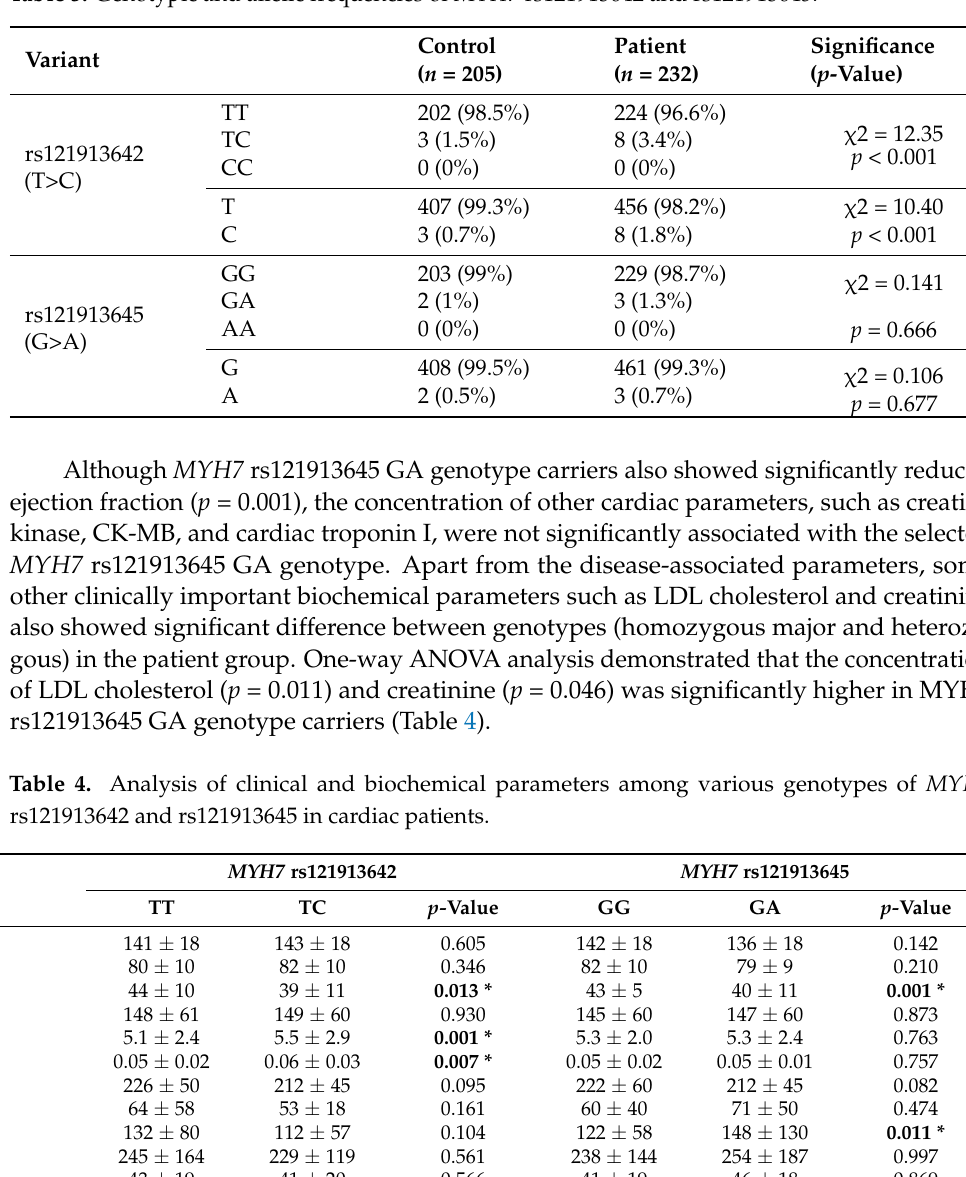
Table 3. Genotypic and allelic frequencies of MYH7 rs121913642 and rs121913645.